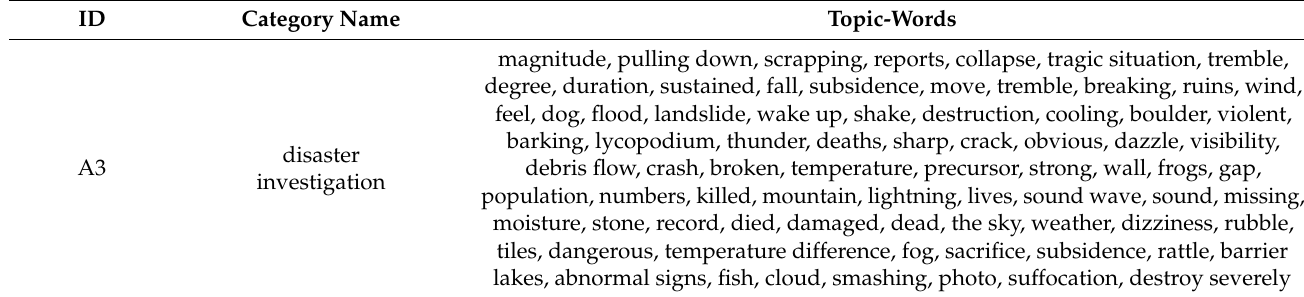
Table 6. Part of the coarse-grained topic-word